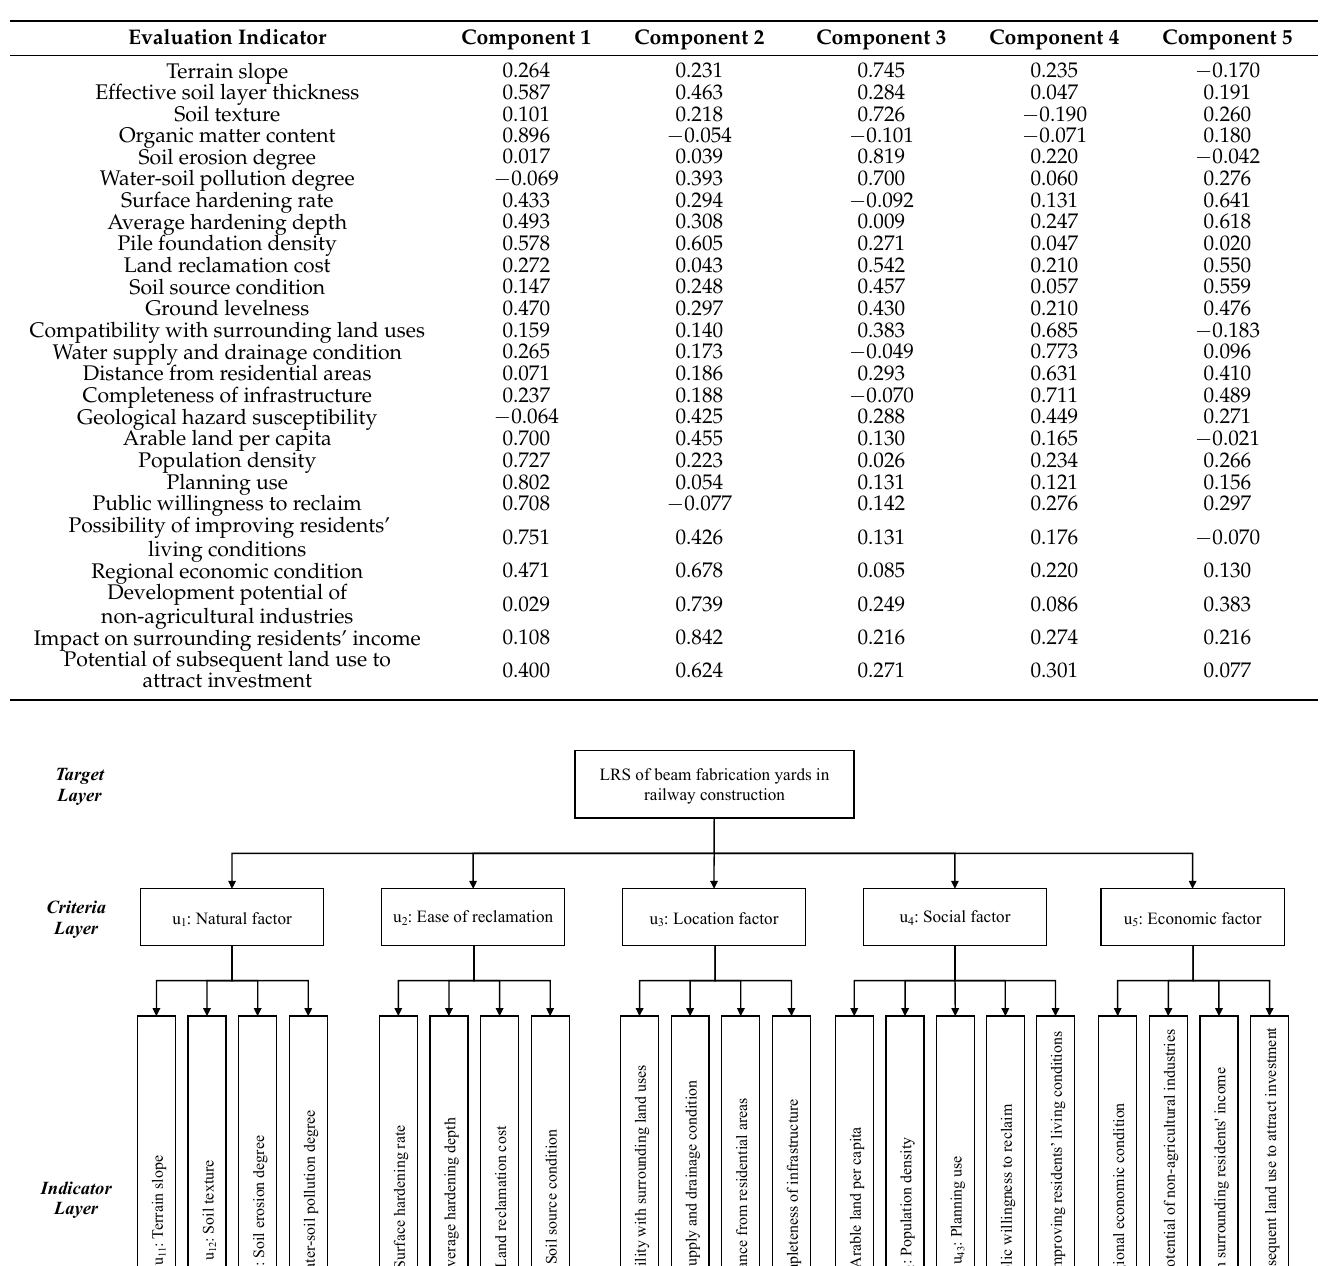
Table 4. Rotated component matrix.